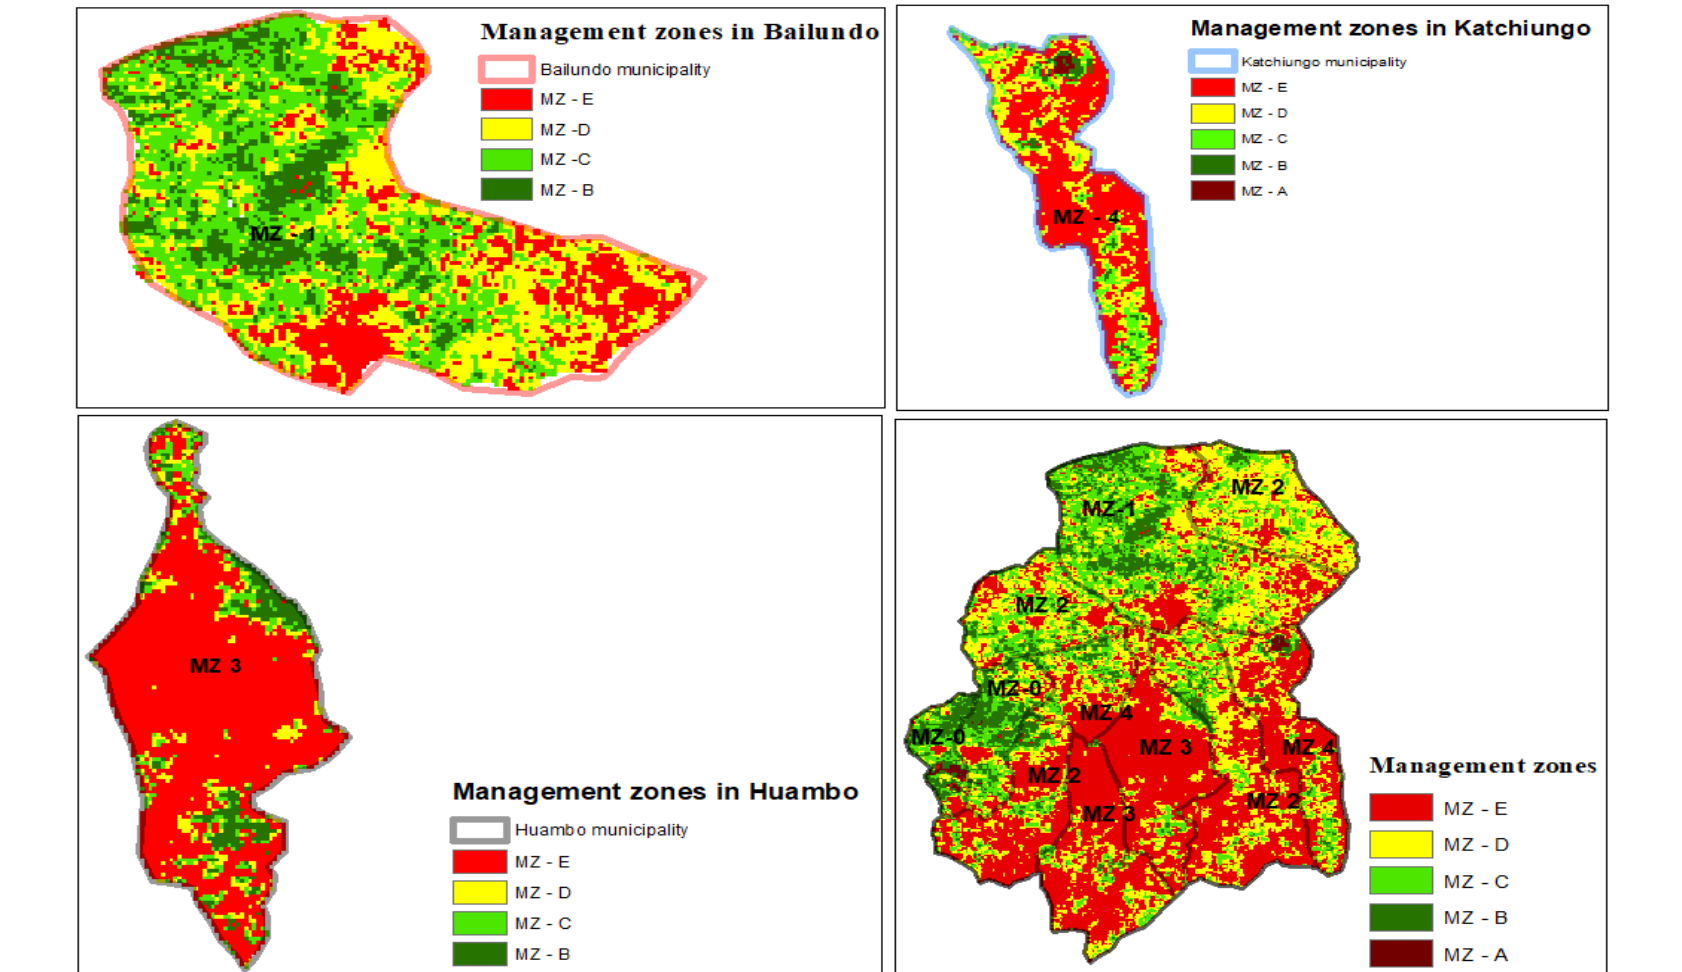
Figure 7. Representation of the suggested management zones.